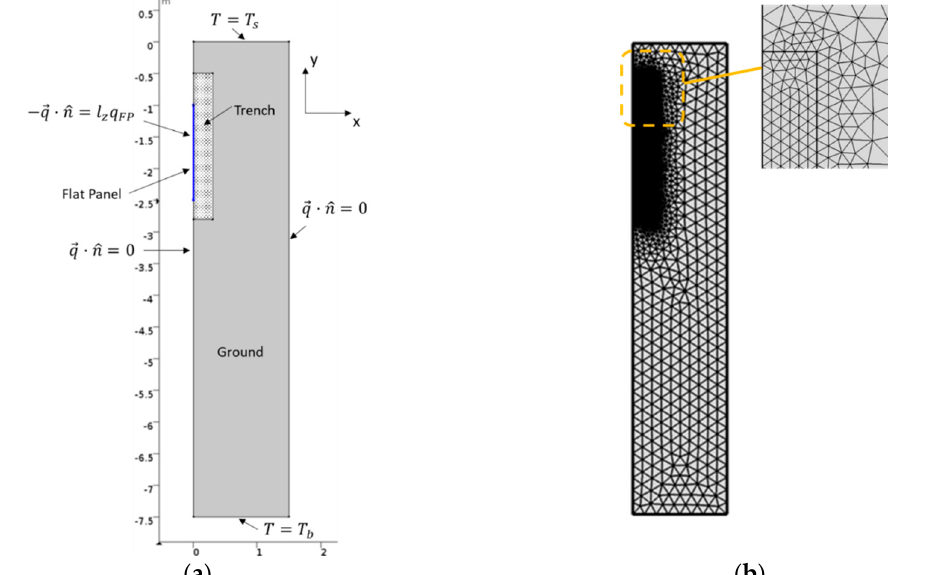
Figure 3. ( a ) Sketch of model domain and boundary conditions. ( b ) Mesh used for numerical solution.